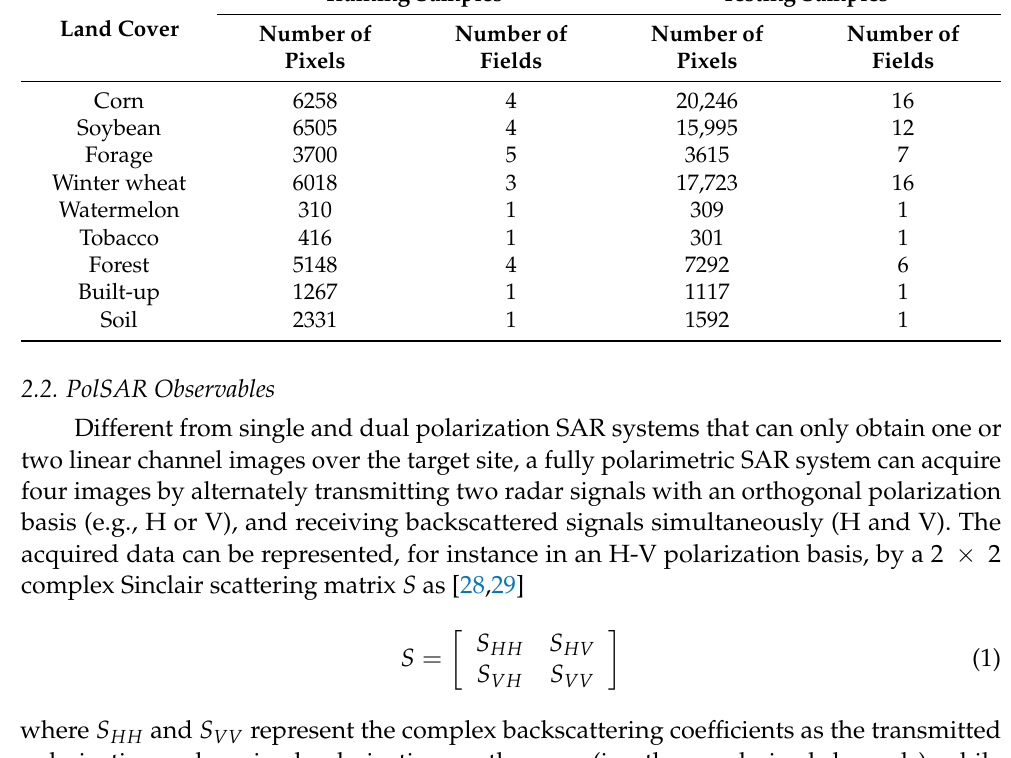
Table 2. The identified crop fields and the number of pixels for classification training and testing. Training Samples Testing Samples Land Cover Number of Number of Number of Number of Pixels Fields Pixels Fields Corn 6258 4 20,246 16 Soybean 6505 4 15,995 12 Forage 3700 5 3615 7 Winter wheat 6018 3 17,723 16 Watermelon 310 1 309 1 Tobacco 416 1 301 1 Forest 5148 4 7292 6 Built-up 1267 1 1117 1